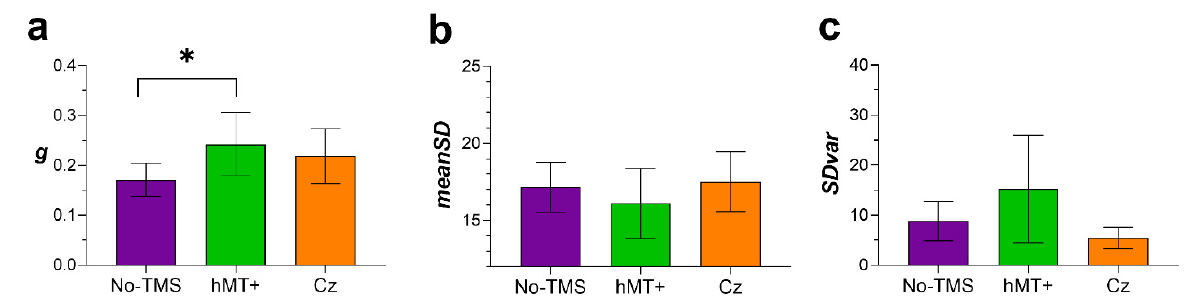
Figure 6. Mean parameters’ estimates of the variable precision model. ( a ) g (random guessing) for No-TMS, hMT+ and Cz. ( b ) MeanSD (mean standard deviation of precision) for the three stimulation conditions. (c) SDvar (intertrial variation in memory precision). The asterisk represents the significant difference between No-TMS and hMT+ for g . Error bars ±SEM.